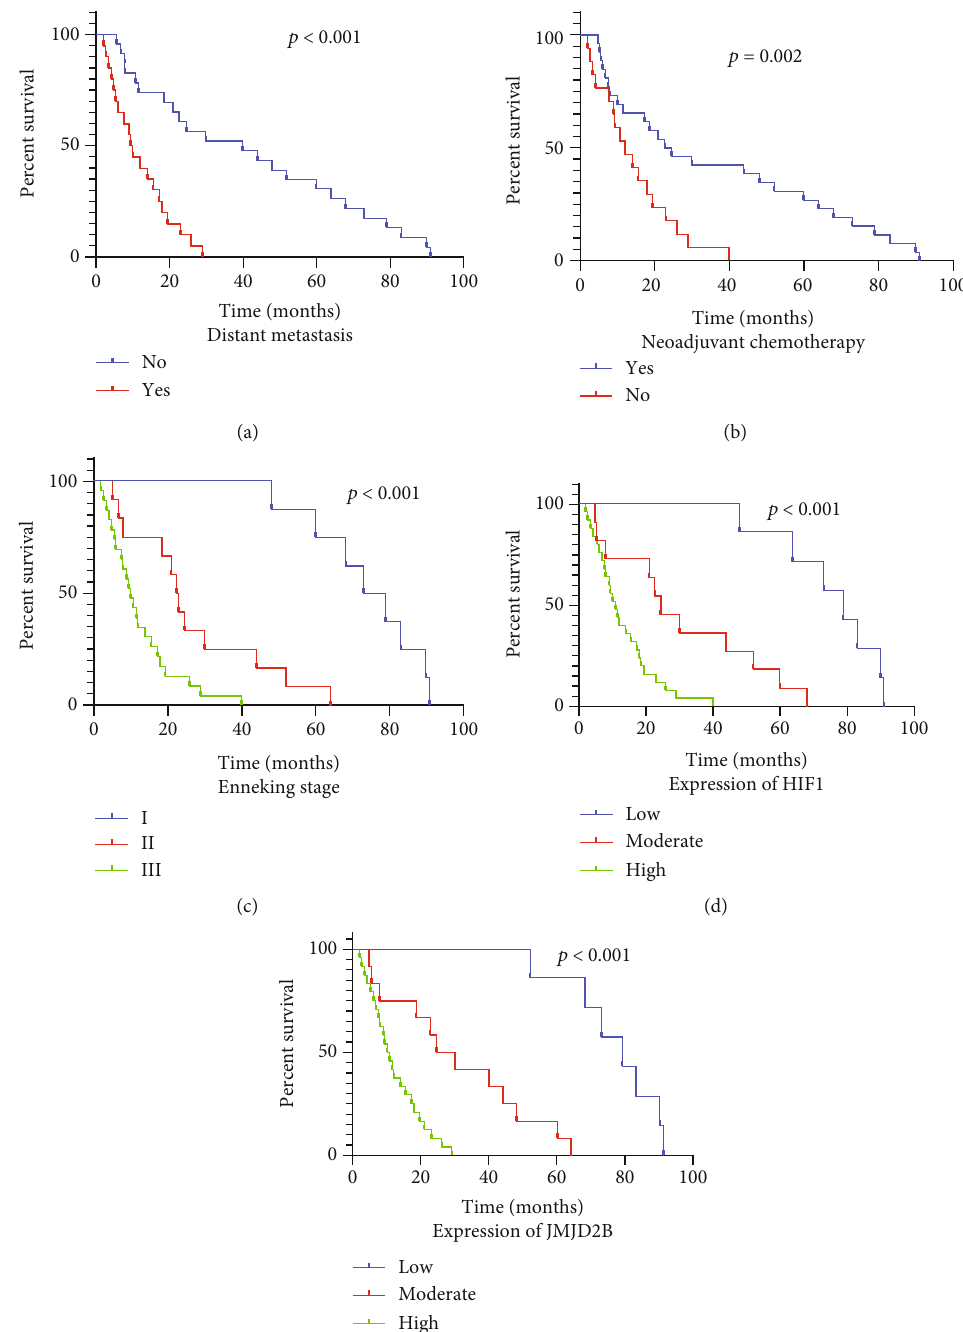
Figure 2: Overall survival curves for OS patients. Association of overall survival with (a) distant metastasis, (b) neoadjuvant chemotherapy, (c) Enneking stage, (d) HIF1 expression, and (e) JMJD2B expression. p values were determined by comparing survival distributions using the log-rank